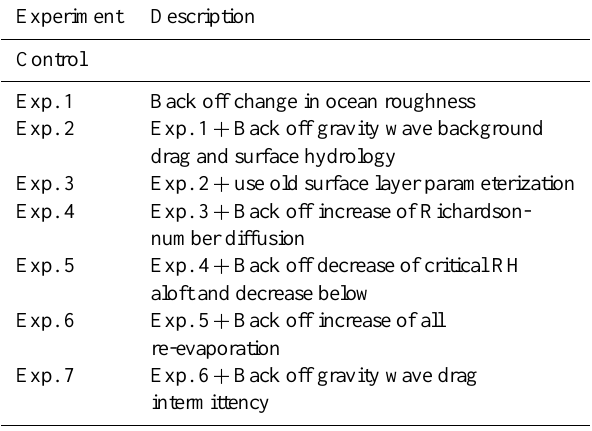
Figure 1. Scatter diagram of surface wind speed (ms − 1 ) vs. ocean roughness (mm) in the MERRA (green) and MERRA2 (black)